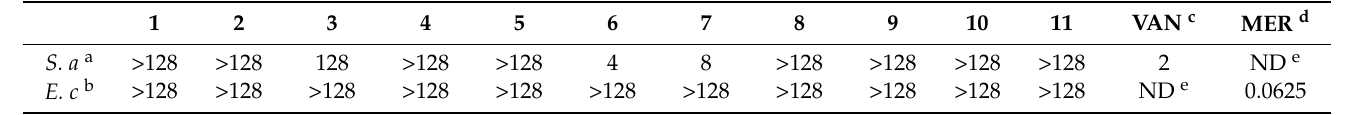
Table 3. MIC ( µ g/mL) values of compounds 1 − 11 against S. aureus and E. coli in